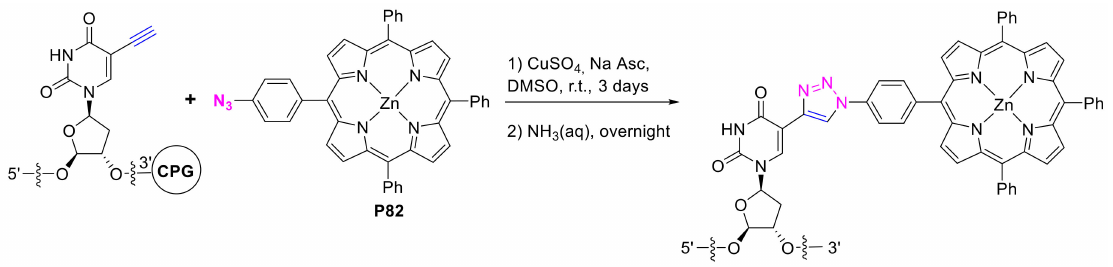
Scheme 29. Synthesis of porphyrin-DNA